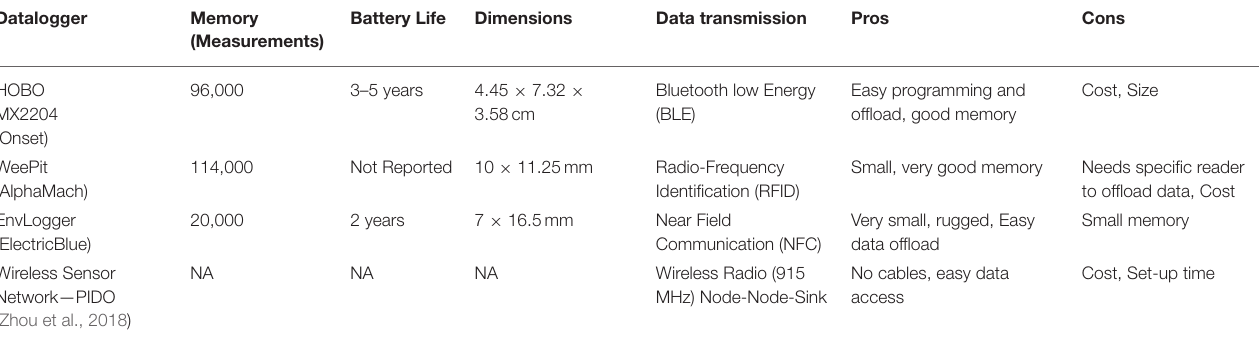
TABLE 2 | New datalogging technologies.